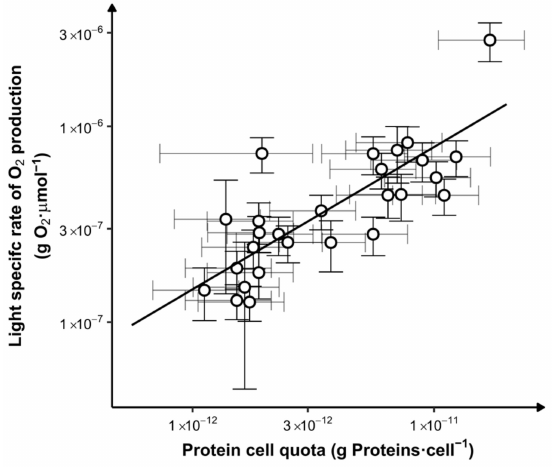
Figure 4. Chlorella vulgaris NIES 227 photosynthetic productivity according to the cell-protein quota (o). The continuous line represents the best fit of Equation (1) of the data collected (R 2 = 0.632, p = 2.04 × 10 − 6 , N =